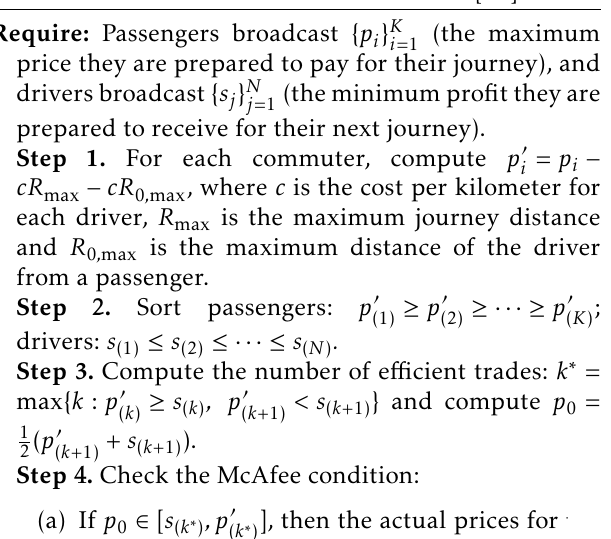
Algorithm 3 Double auction mechanism pricing and allocation based on the McAfee mechanism [26].